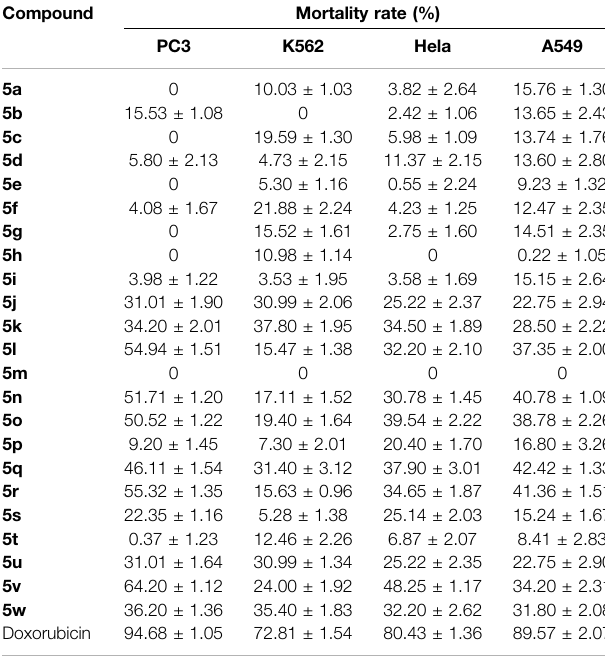
TABLE 3 | The anticancer activities of the title compounds 5a − 5w at 5 μ g/ml. Compound Mortality rate